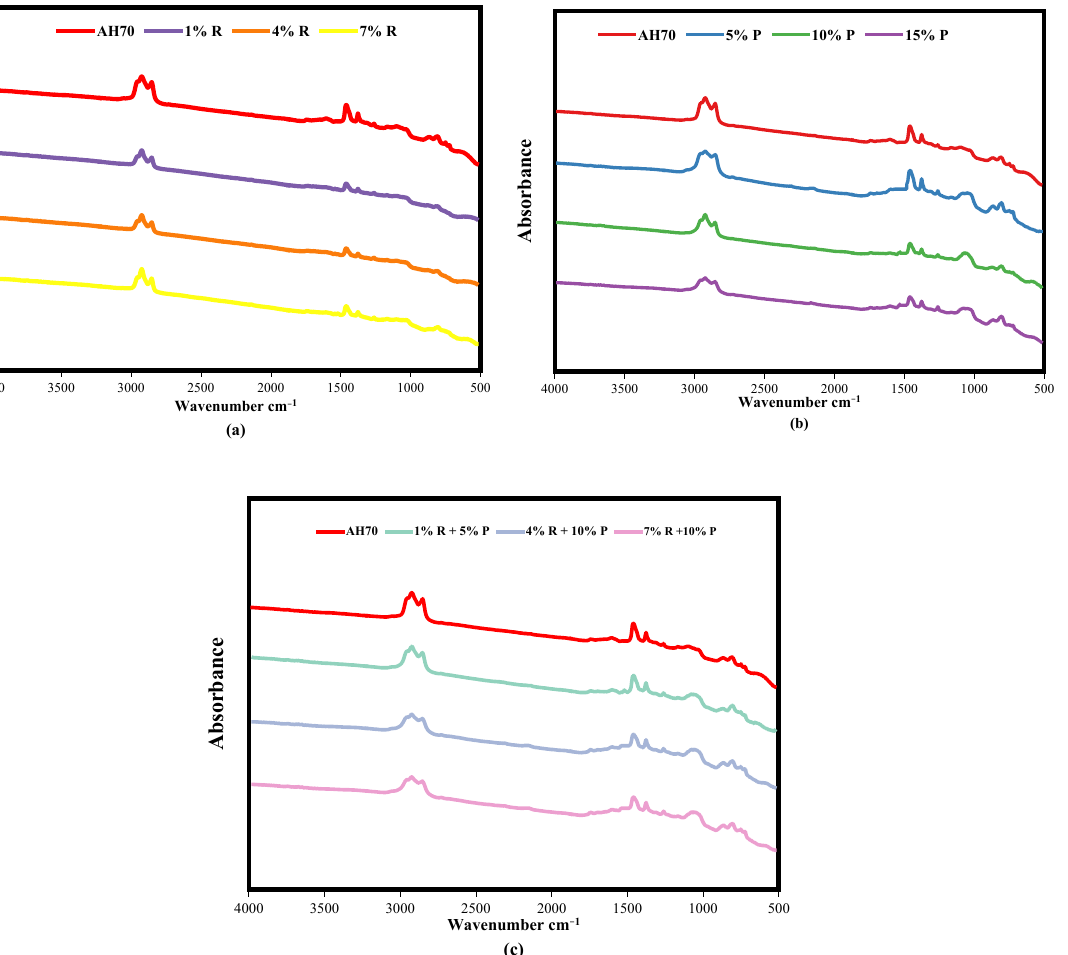
Figure 13. FTIR spectra of ( a ) R-modified asphalt, ( b ) P-modified asphalt, ( c ) (1% R + 5% P), (4% R + 10% P), and (7% R + 10% P)-modified asphalt after RTFO aging.